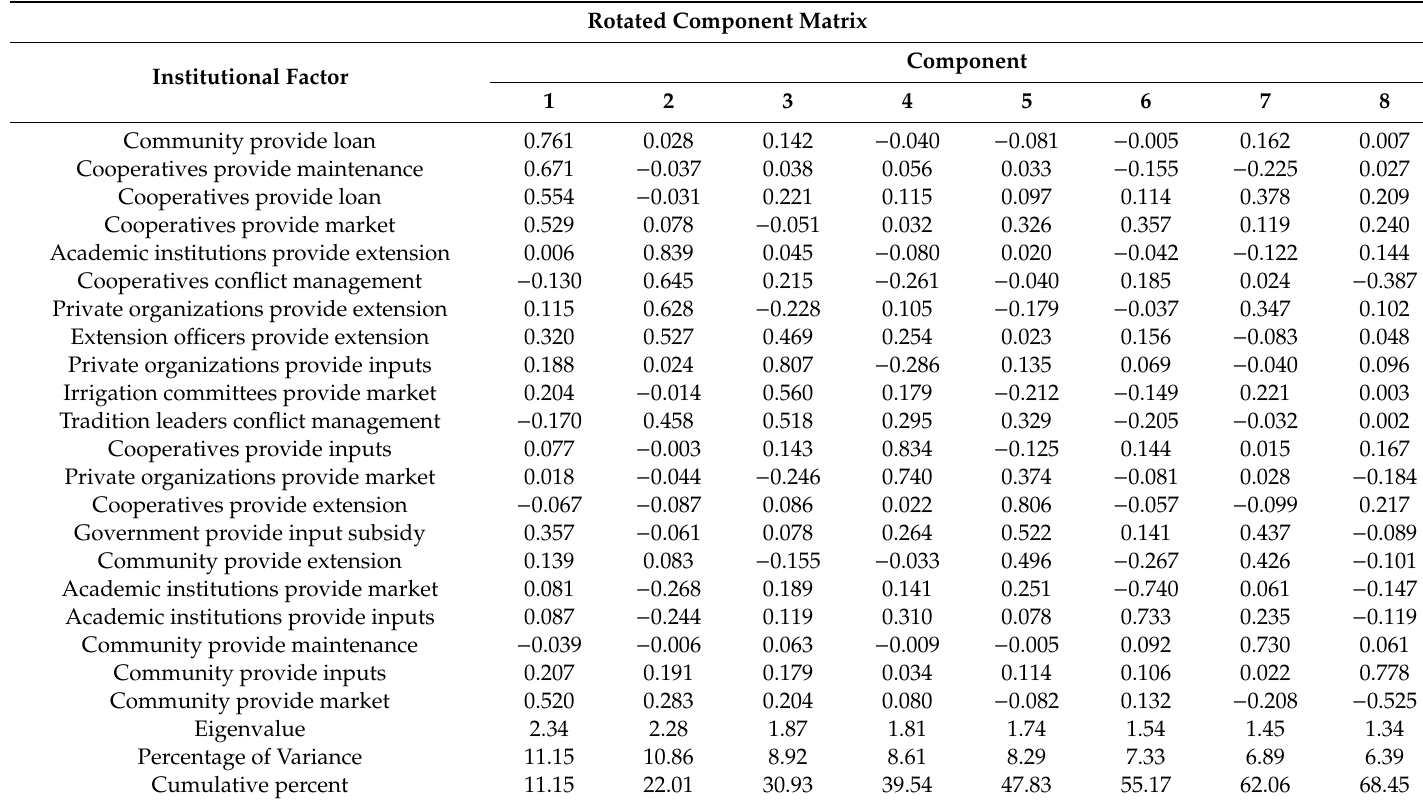
Table 6. Principal component analysis (PCA) results on the proportion of institutional factors on principal components. Rotated Component